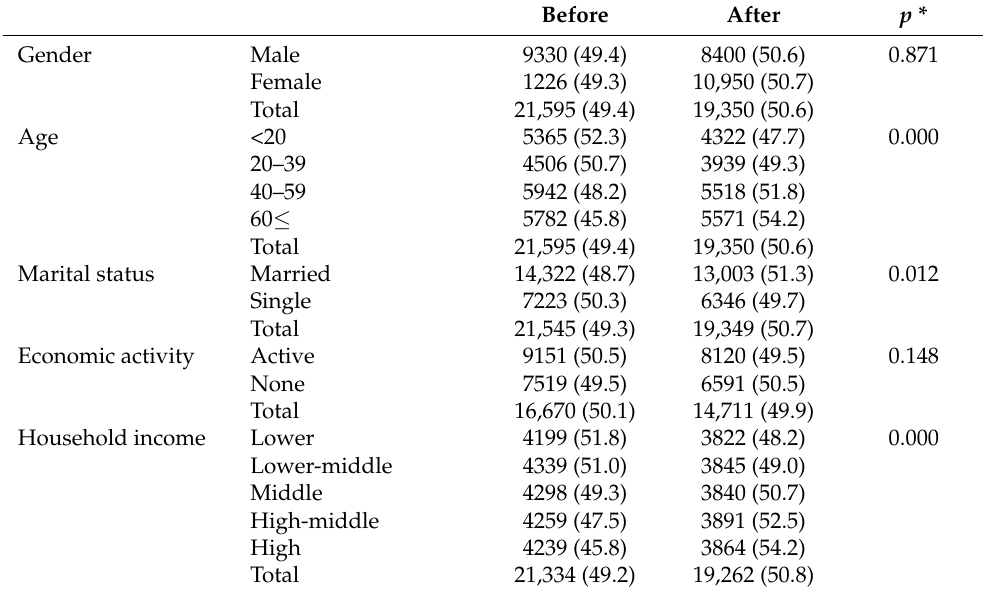
Table 1. Comparison of the subjects’ demographic characteristics (Unit: %).